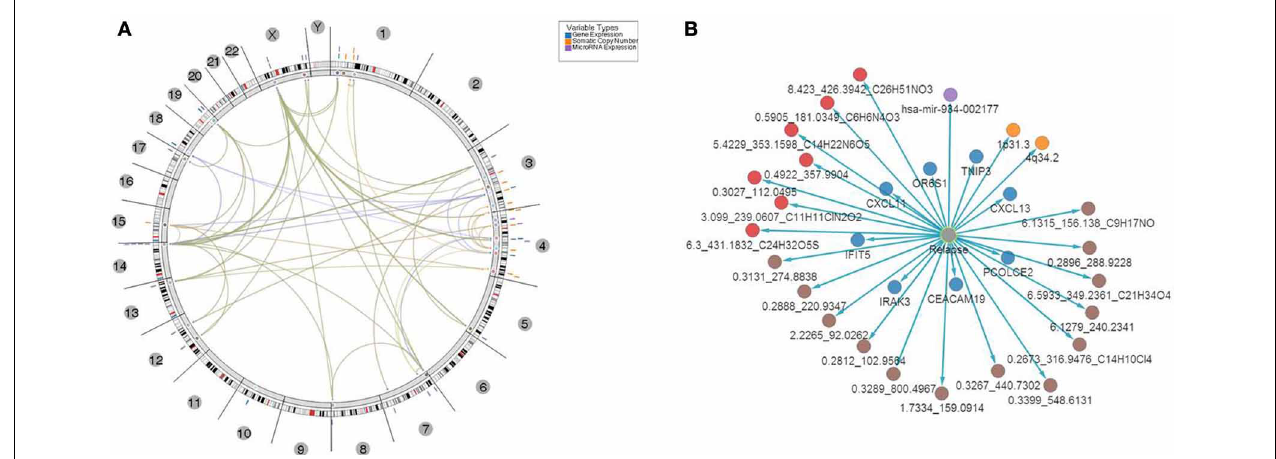
FIGURE 7 | Top 31 features associated with relapse. (A) Results of multivariate analysis and integration of tissues-based and bio-fluid based top omics features. Features were mapped onto genomic coordinates on a circos plot, with edges indicating pairs of features with significant association of